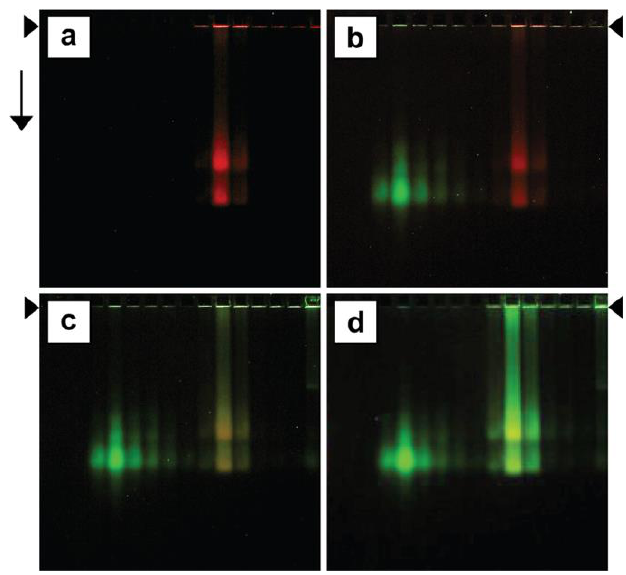
Figure 4. Post-AGE GelStar staining. After the orange-filtered image of Figure 2c was recorded, the same gel was stained with GelStar. Images were recorded with a yellow filter ( a ) before staining with GelStar, ( b ) 2 h after staining with GelStar in electrophoresis buffer, ( c ) 3 h after continuing the GelStar staining in 0.002 M EDTA, pH 7.4 and ( d ) 16 h after further continuing the staining in panel ( c ). The arrowheads indicate the origins of electrophoresis; the arrow indicates the direction of electrophoresis.